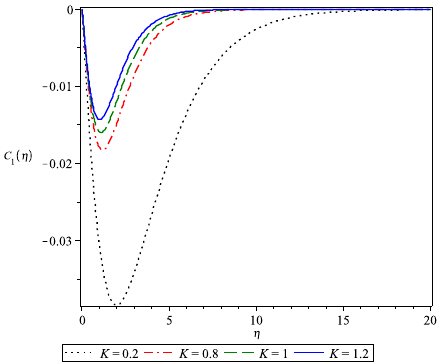
Figure 8. Dependency of concentration profile C 1 on the chemical reaction parameter K when N = 0.8 and Sc = 0.24.